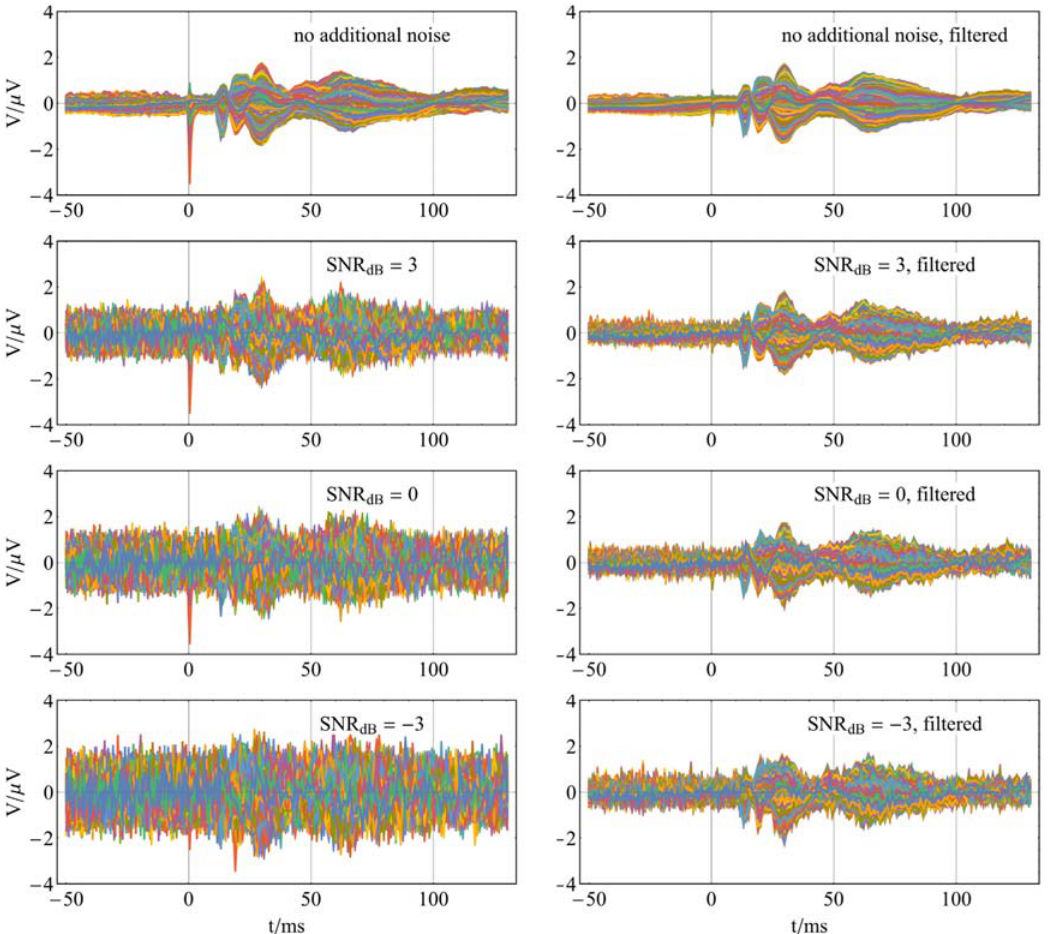
Fig 9. Example of noise suppression using spatial harmonic low pass filter. Left column unfiltered data, right column spatial harmonic low-pass filtered data; in the first row averaged SEP data without additional noise; in the following rows SEP data with additional Gaussian white noise with 3, 0, -3 dB signal to noise